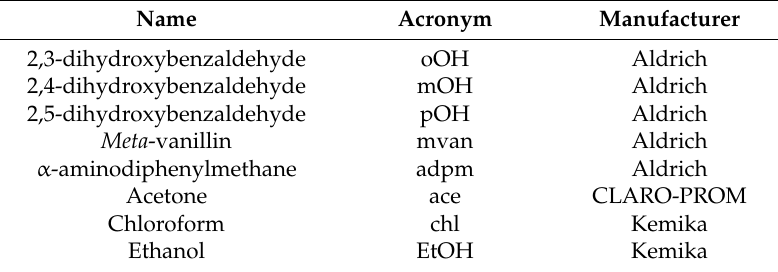
Table A1. Starting materials used for various experiments.